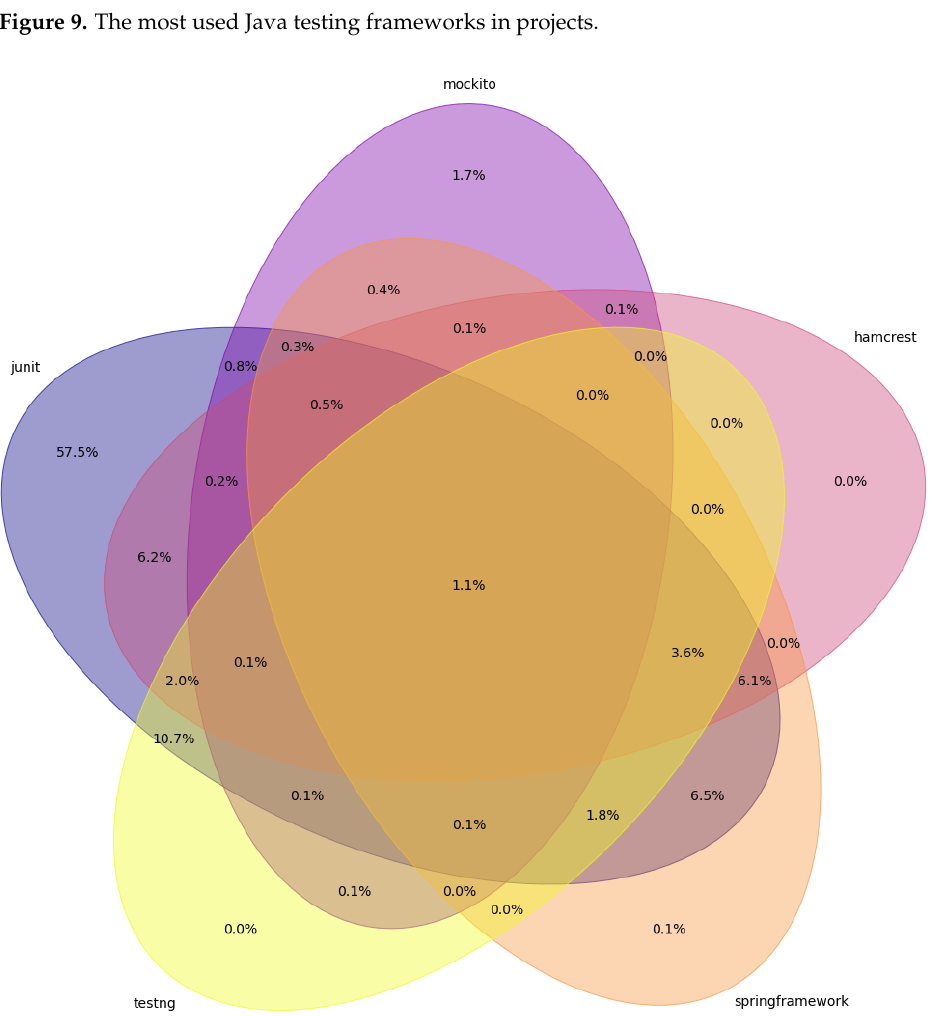
Figure 10. The first 5 simultaneously used testing